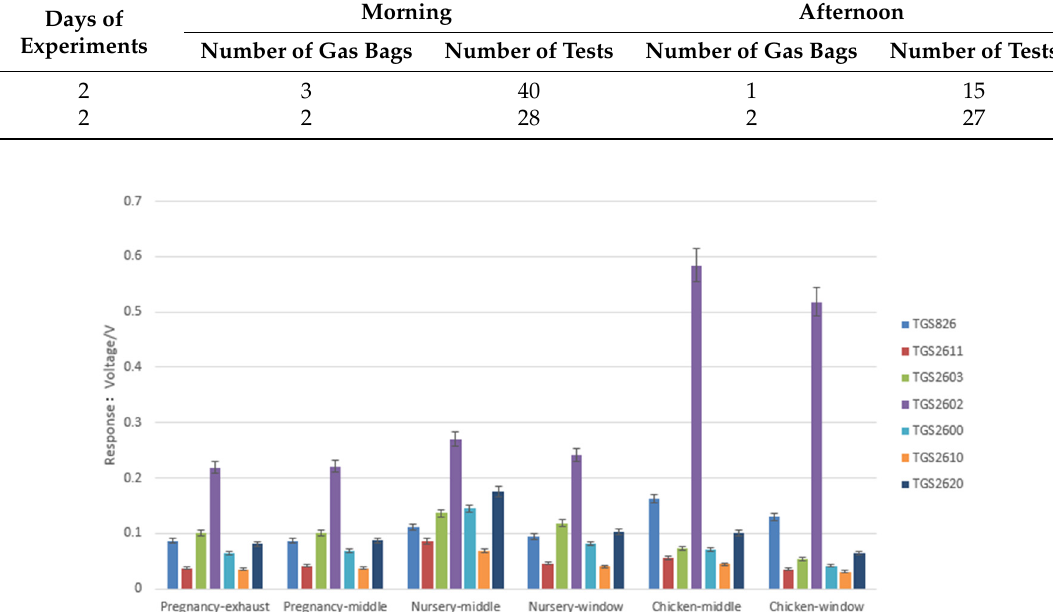
Figure 4. The average of the maximum voltage calculated from the electronic nose sensor re-